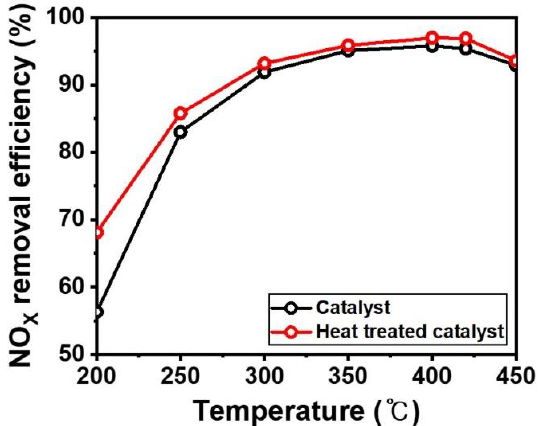
Figure 7. NOx removal efficiency of V 2 O 5 -WO 3 /TiO 2 (black line) and heat-treated V 2 O 5 -WO 3 /TiO 2 (red line). Reaction conditions: [NO] = 240 ppm [NH 3 ] = 288 ppm, [SO 2 ] = 600 ppm, [O 2 ] = 3 vol.%, [area velocity ] = 25 m/h.